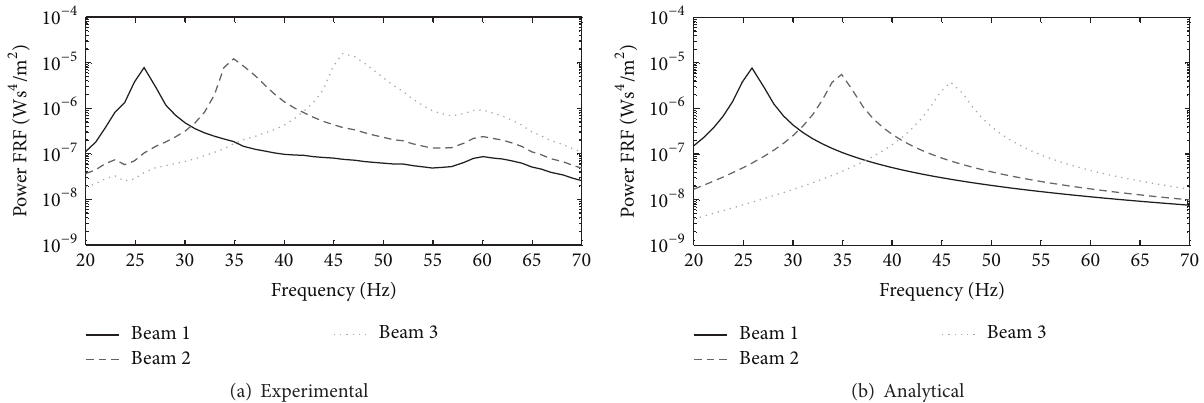
Figure 13: Power FRF for the three beams with no springs and independent electrical connections to 1 k Ω resistive loads: (a) experimental measurement, (b) analytical results.